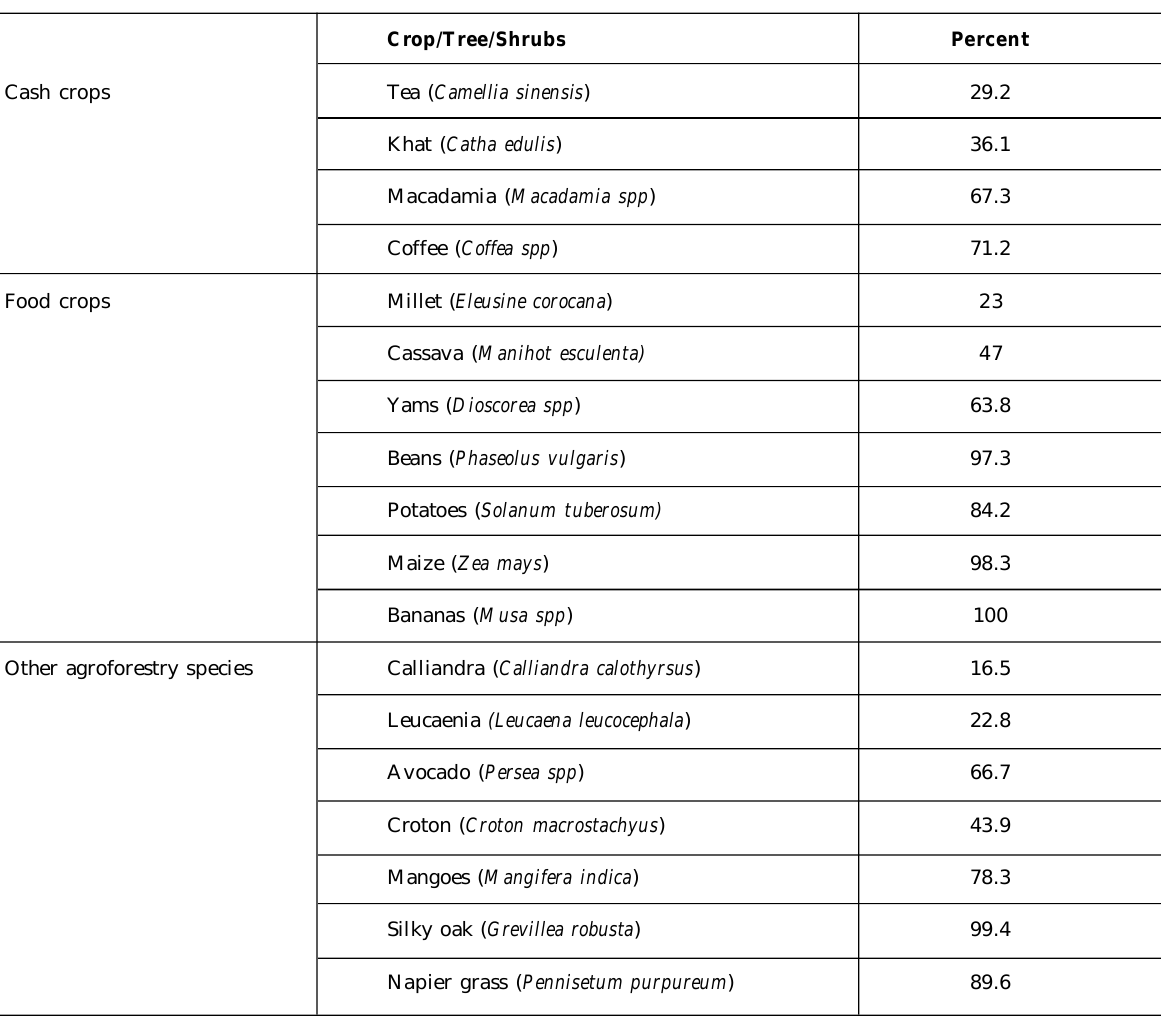
Table 4: Main crops and agroforestry tree species found in Embu County Crop/Tree/Shrubs Percent Cash